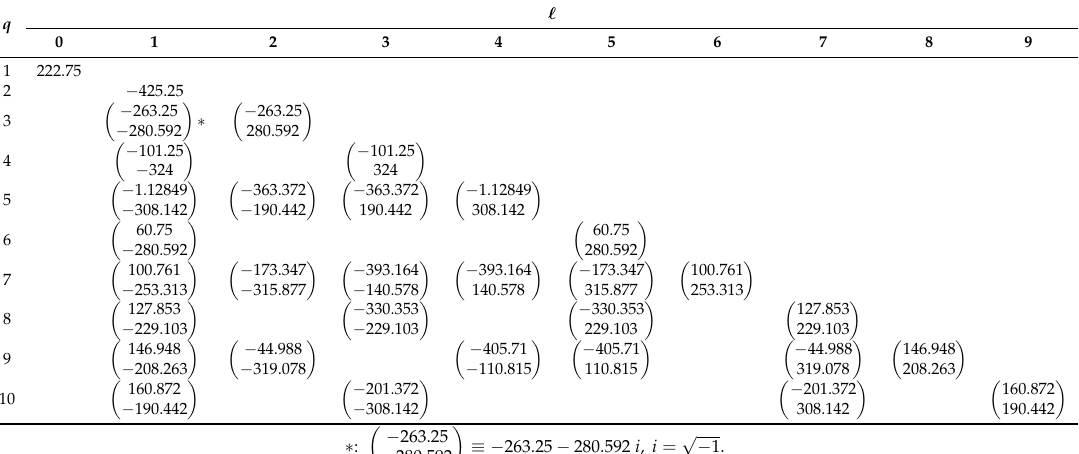
Table 2. Selected (cid:96) / q –bifurcation points λ (cid:96) , q for 1 ≤ q ≤ 10.